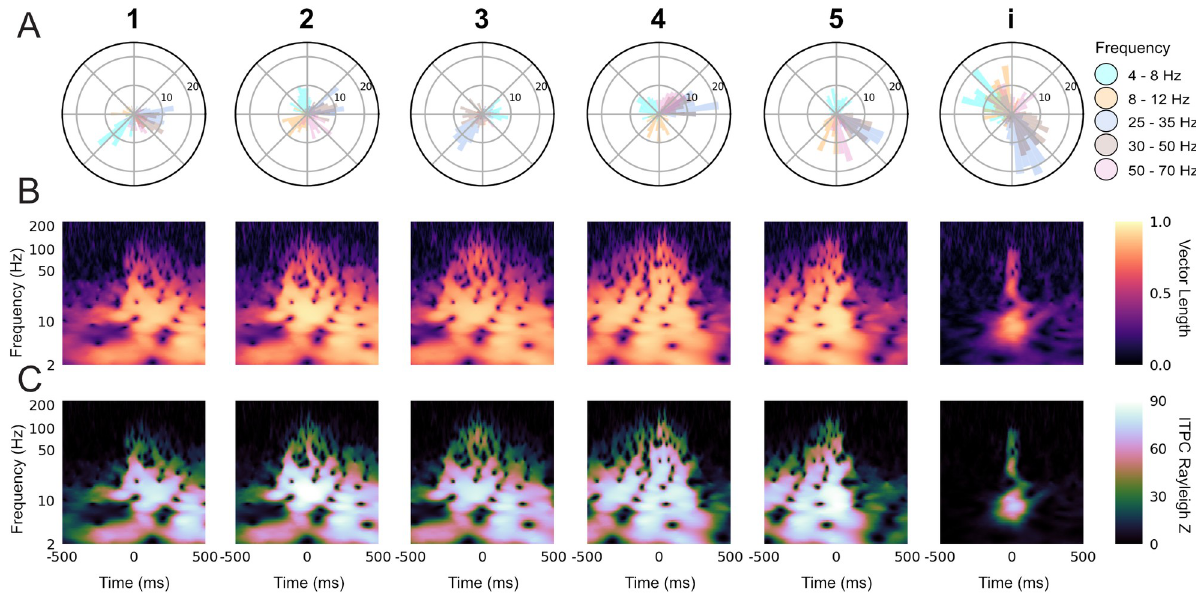
Fig 7. Syllable specific inter-trial phase coherence reveals phase preference to syllable onset. (A) Polar histogram of the phase for each LFP frequency band at the labeled start of all instances of a given syllable or the introductory note over the course of one day (Day 2), for bird z007 (S3 Table). (B) ITPC resultant vector length, indicating the level of phase consistency across trials, for each frequency over time relative to the labeled start of each syllable or introductory note (0 ms) over randomly downselected instances from (A) to match the number of instances per syllable. (C) Rayleigh Z-statistic of the ITPC over the same time and frequencies as (B) (p < 0.007 for all Z > 5 for all syllables; all non-black time-frequency points in these plots are above the significance threshold). For (B) and (C) the number of instances (n = 98) are equal for all syllables and the introductory note, and is set by the syllable class with the fewest